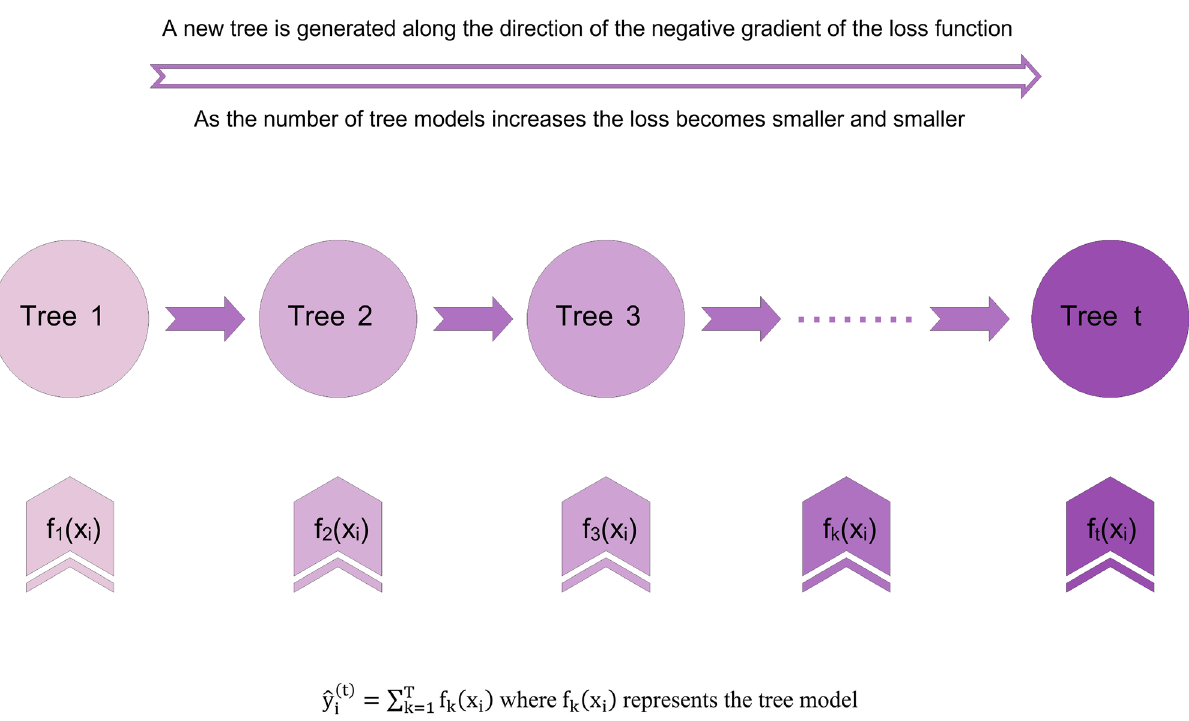
Figure 1. Schematic of XGBoost